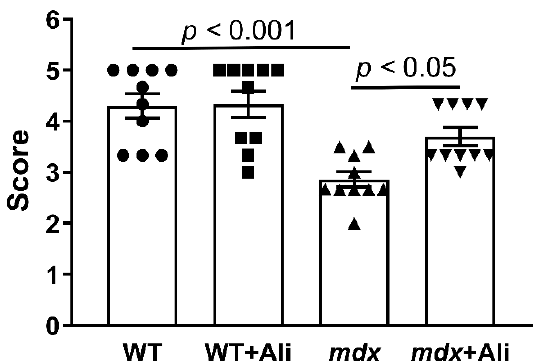
Figure 2. The results of a wire hang test, reflecting muscle function and endurance of the studied groups of mice. The data are presented as means ± SEM ( n = 10).